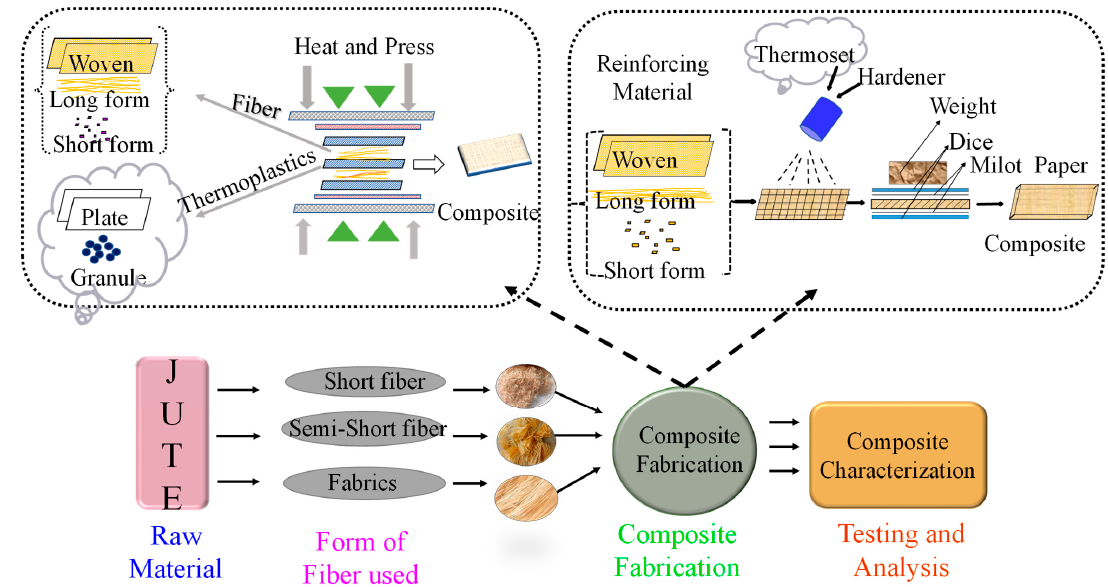
Figure 14. Composite fabrication using the hot press and hand lay-up